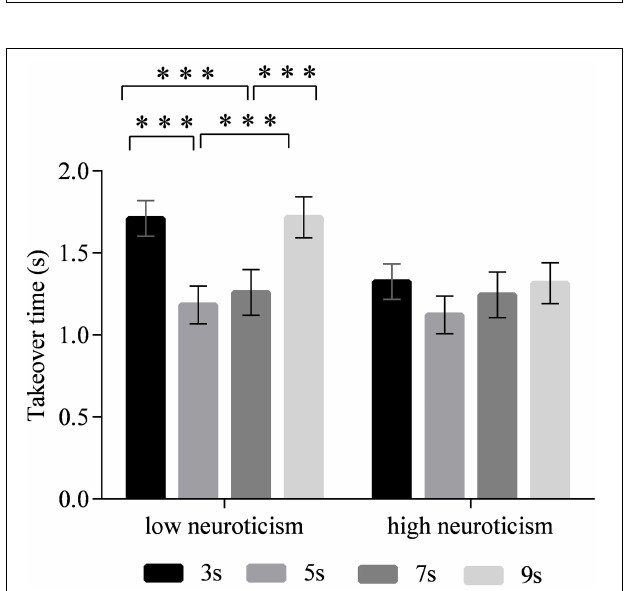
FIGURE 4 | Takeover time of different time intervals for drivers with the low and high neuroticism. (Notes. *** p < 0.001).